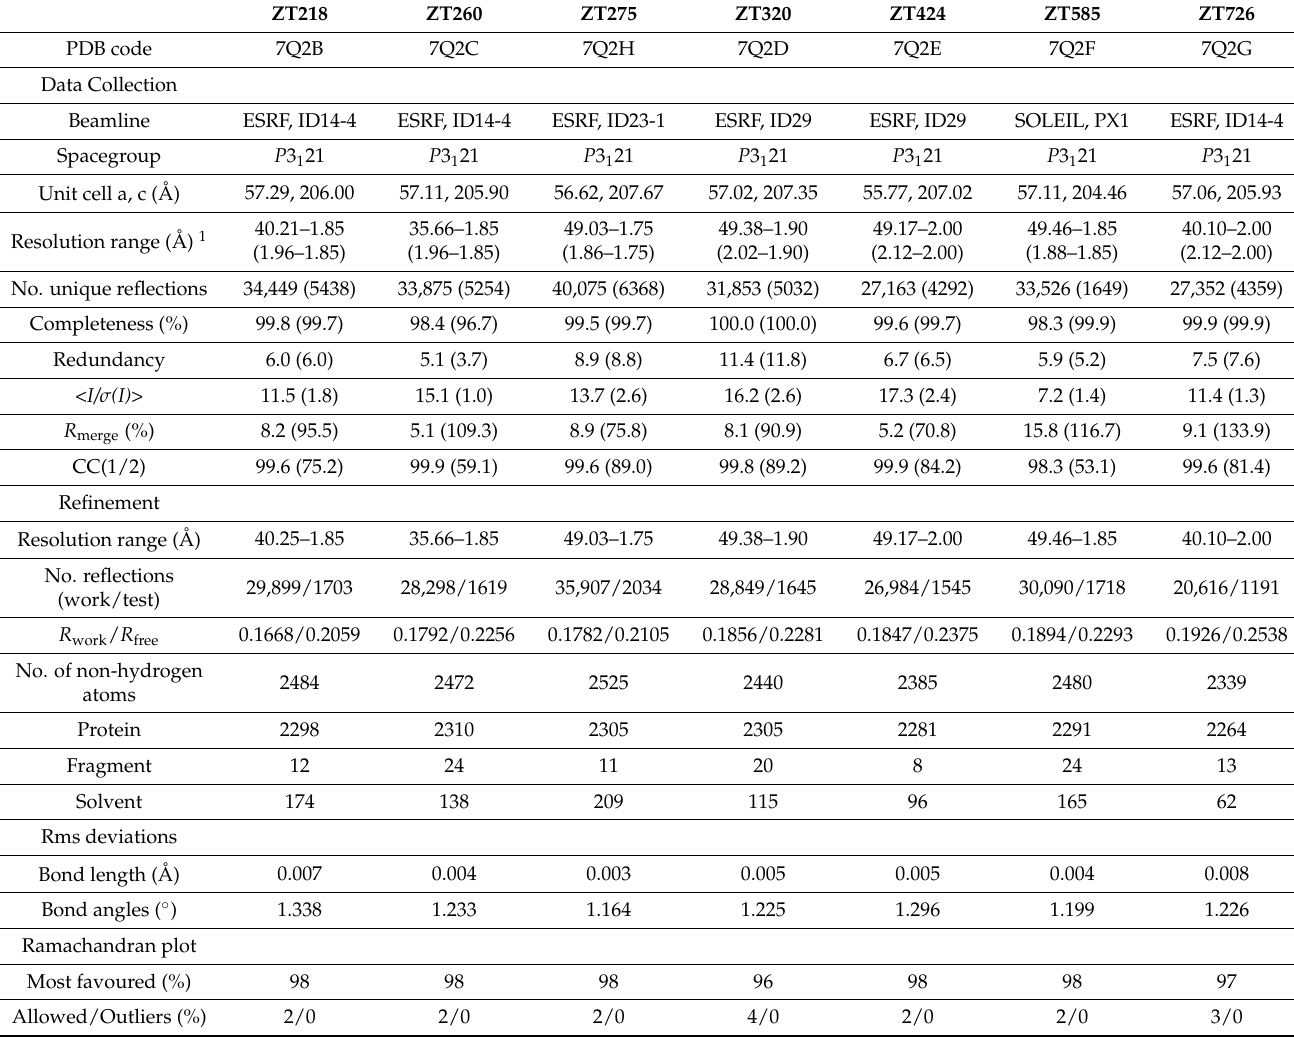
Table 1. Data collection and refinement